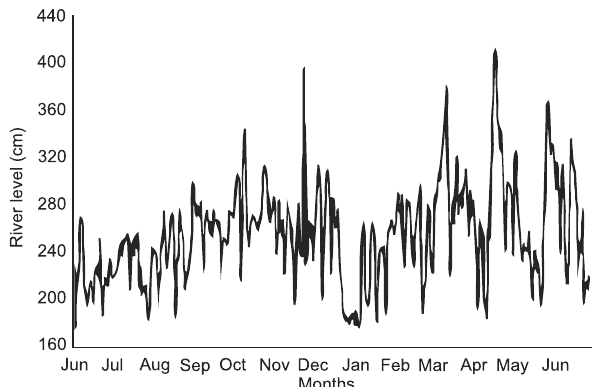
Figure 2. Daily values of the level of Paraná River during the pe- riod from June 2003 to June 2004, recorded in the Field Station of the Núcleo de Pesquisas em Limnologia, Ictiologia e Aquicultura (Nupélia) in Porto Rico, Paraná